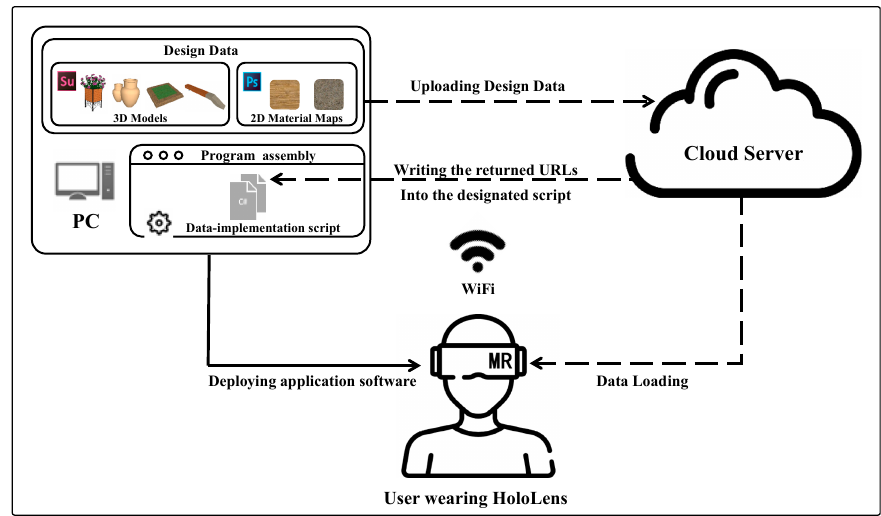
Figure 4. The design data preparation process.